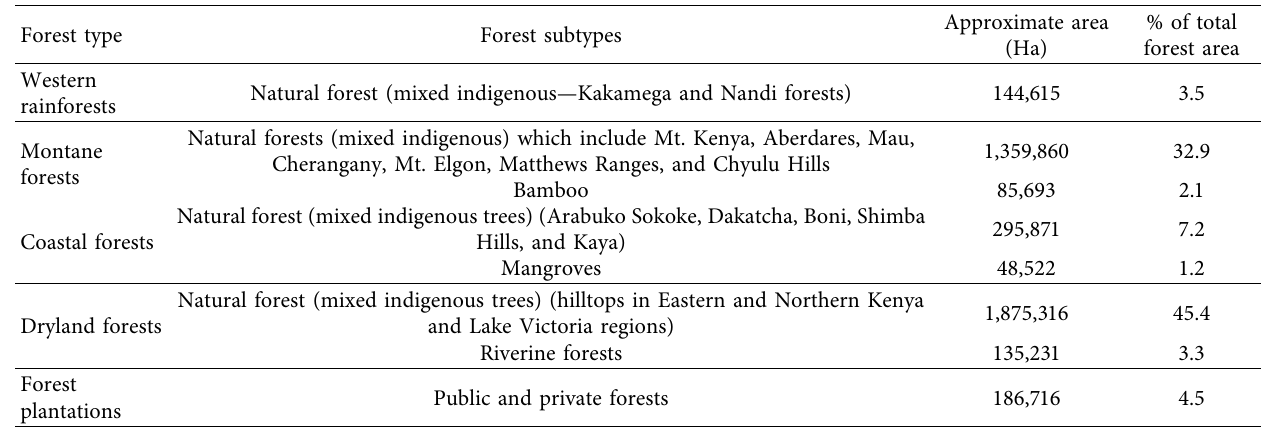
Table 2: Forest types in Kenya.